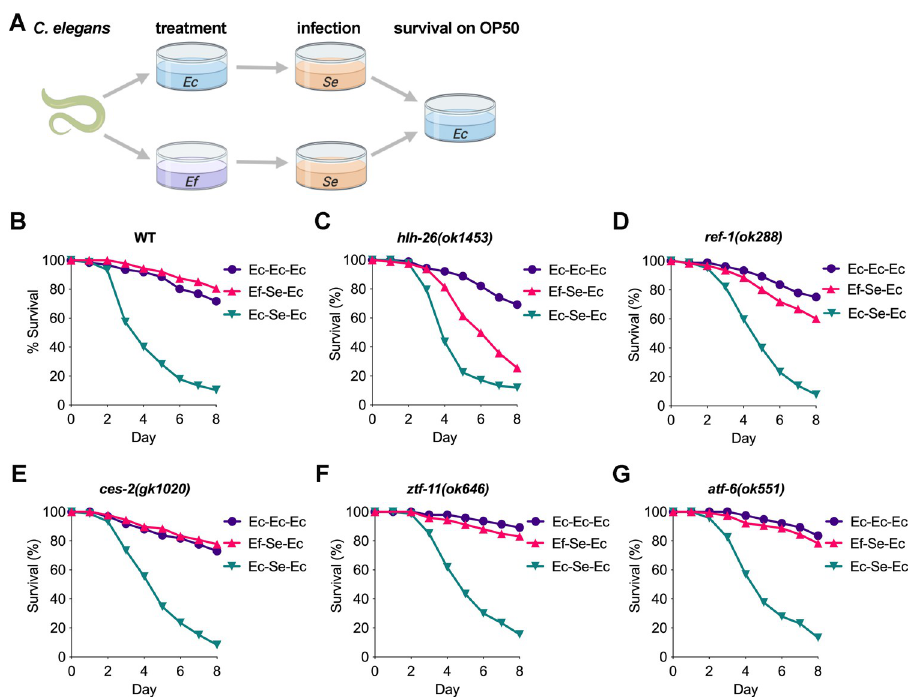
Fig 1. E . faecium protection in wild-type and mutant C . elegans . (A) Schematic of the treatment–1-day infection assay. Worms were treated on E . faecium lawns for 1 day before infection with S . enterica for 1 day. Worms were then transferred onto E . coli OP50 plates for the remainder of the assay, and survival was scored. (B) Survival curve from a treatment–1-day infection assay showing that E . faecium inhibits S . enterica pathogenesis. Survival curve showing E . faecium –mediated protection in (C) hlh-26(ok1453) , (D) ref-1(ok288) , (E) ces-2(gk1020) , (F) ztf-11(ok646) , and (G) atf- 6(ok551) . Survival curves are representative assays of 3 independent experiments. n = 60 to 90. The data underlying all the graphs shown in the figure can be found in S1 Data. Ec AU : AbbreviationlistsinFigs 1 (cid:0) 6 havebeenupdated : Pleaseverifythatallentriesarecorrect : , E . coli OP50; Ef, E . faecium ; Se, S . enterica ; WT, wild-type. https://doi.org/10.1371/journal.pbio.3001581.g001 and found that the protection was not as strong as that of live E . faecium (S1 Fig), indicating that live probiotic is required for full protection. Thus, using live probiotic treatment followed by a 1-day pathogen exposure assay (Fig 1A and 1B), we studied the 5 top-ranked matching TFs (Table 1) and found that the survival of hlh-26 ( ok1453 ) and ref-1 ( ok288 ) animals fed E . faecium before infection decreased (Fig 1C and 1D). In contrast, no changes were observed in